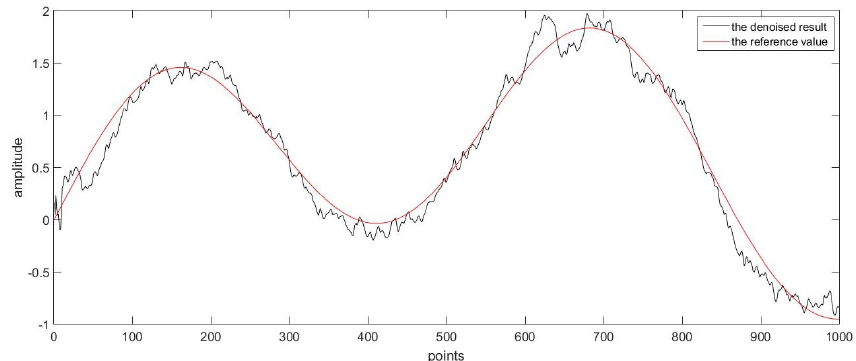
Figure 10. The reference value and the denoised result.